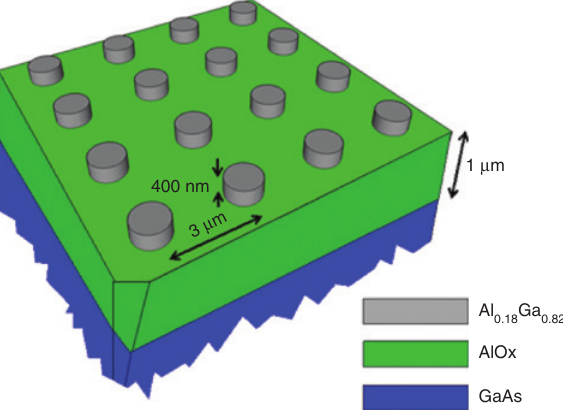
Figure 1: Schematic view of the AlGaAs-on-AlOx nanocylinder array.